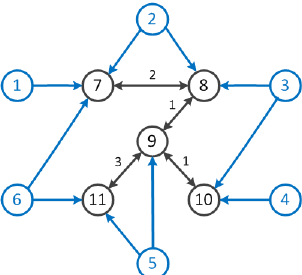
Figure 4. Symmetric topology of agents.